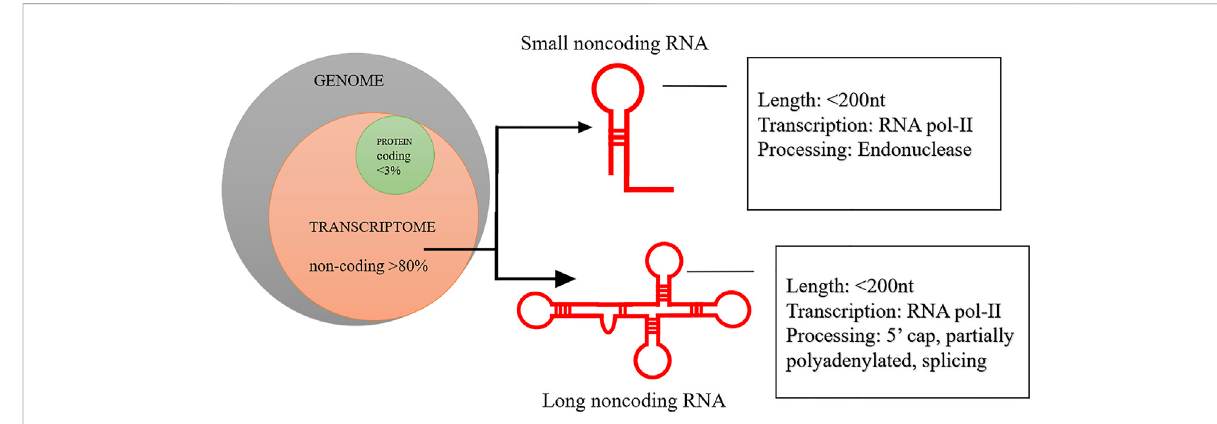
FIGURE 1 Schematic representation of genomic proportion for coding and noncoding RNA. More than 80% of human genome is noncoding and has genes for different population of noncoding